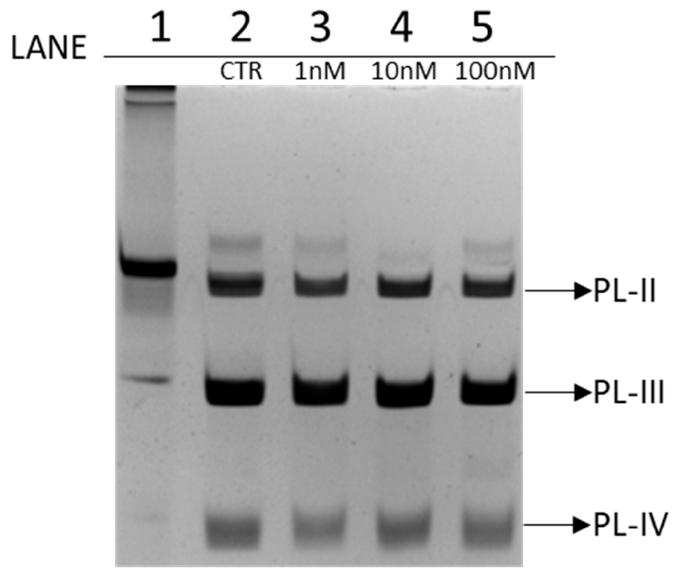
Figure 1. AU-PAGE of PLs extracted from mussels. Lane (1) Chaetopterus variopedatus sperm H1 Histone; lane (2) PL extracted from unexposed mussels (CTR, ie control); lanes (3–5) PL extracted from mussels exposed to 1, 10, and 100 nM chromium (VI), respectively. CTR = unexposed mussels.